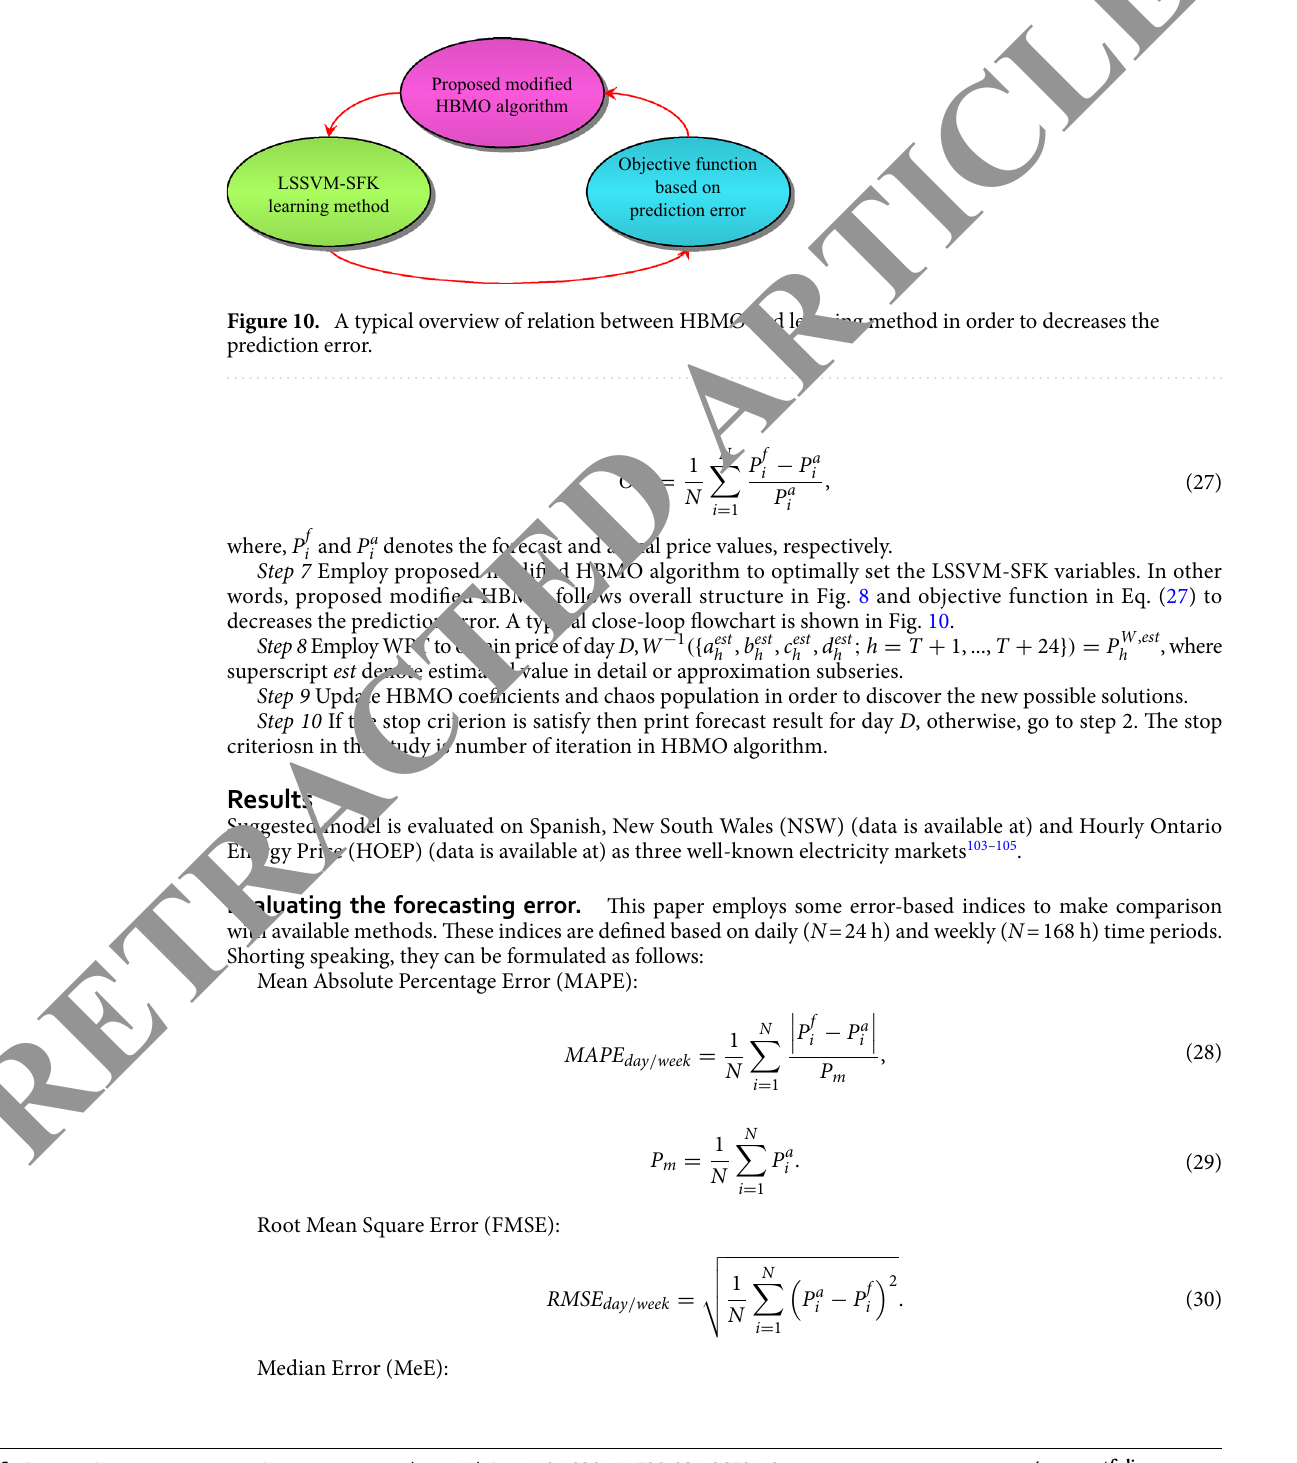
Figure 9. Proposed time framework for price forecasting.